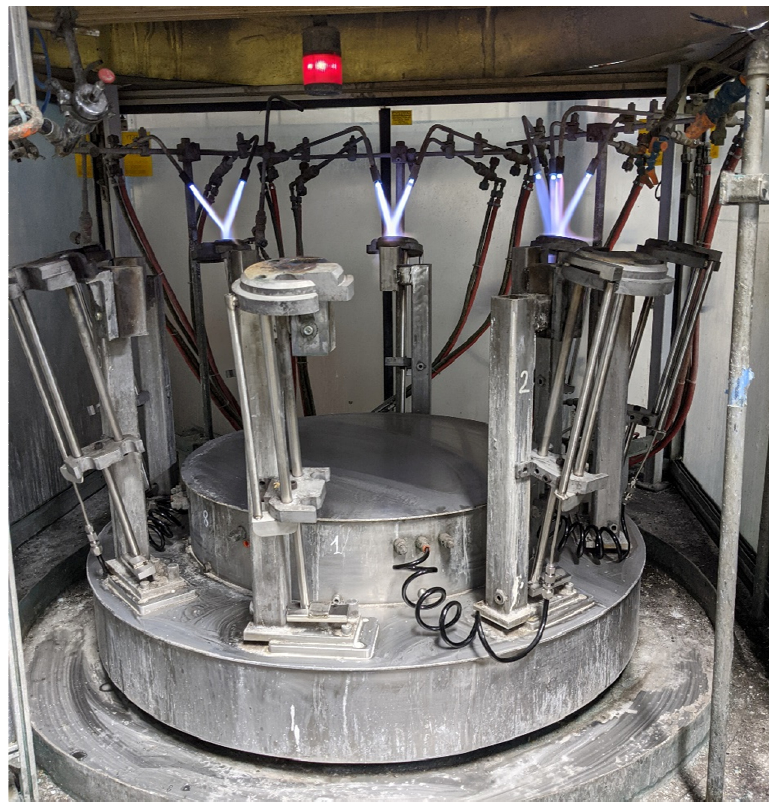
Figure 4. Automatic Brazer with the gas burners on.